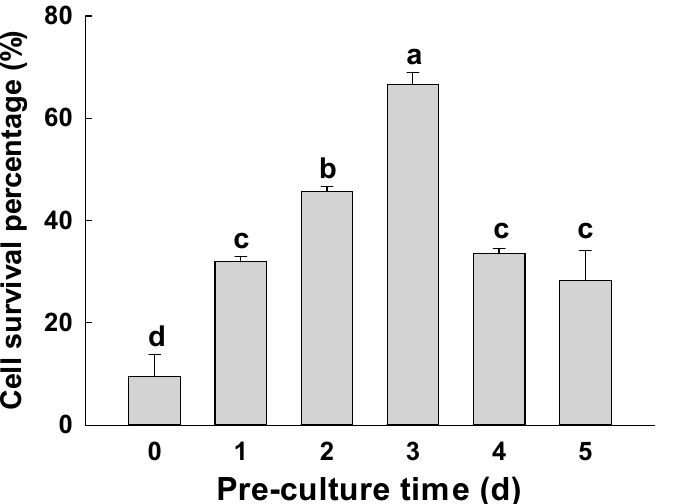
Figure 2. Effects of pre-culture time on cell survival percentage of F. mandshurica EC after cryopres- ervation by vitrification. Note: Different letters are significantly different from each other at p < 0.05, using Duncan’s Multiple Range Test.